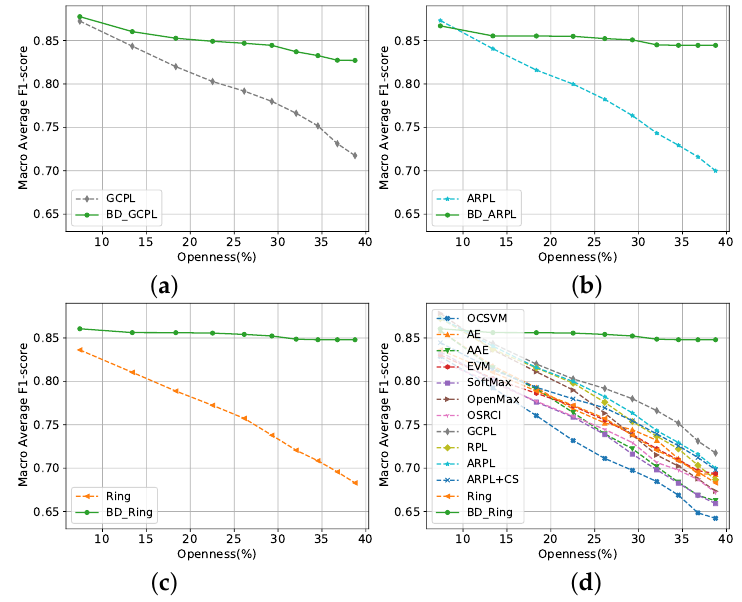
Figure 7. ( a – c ) show the greatly improved performance of the proposed method in combination with the selected loss function under different O , and ( d ) shows the performance comparison results between the various methods under different O ; ( a ) GCPL; ( b ) ARPL; ( c ) Ring; ( d ) All